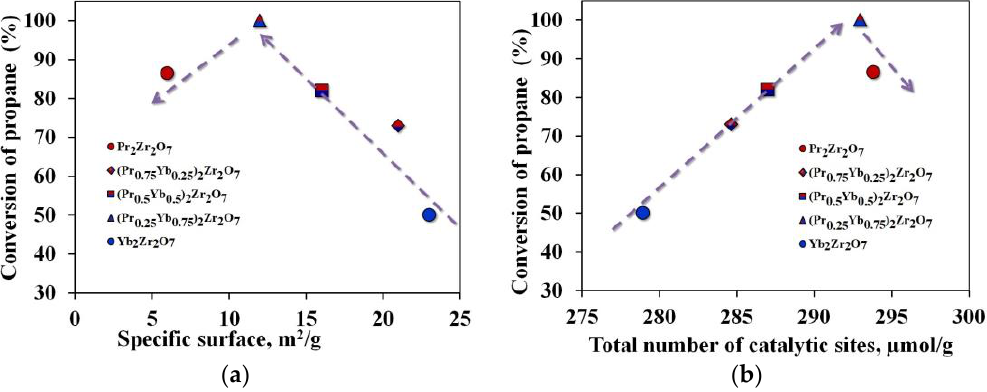
Figure 7. Propane conversion rates depending on: ( a ) — specific surface area, ( b ) — number of electron-withdrawing centers.